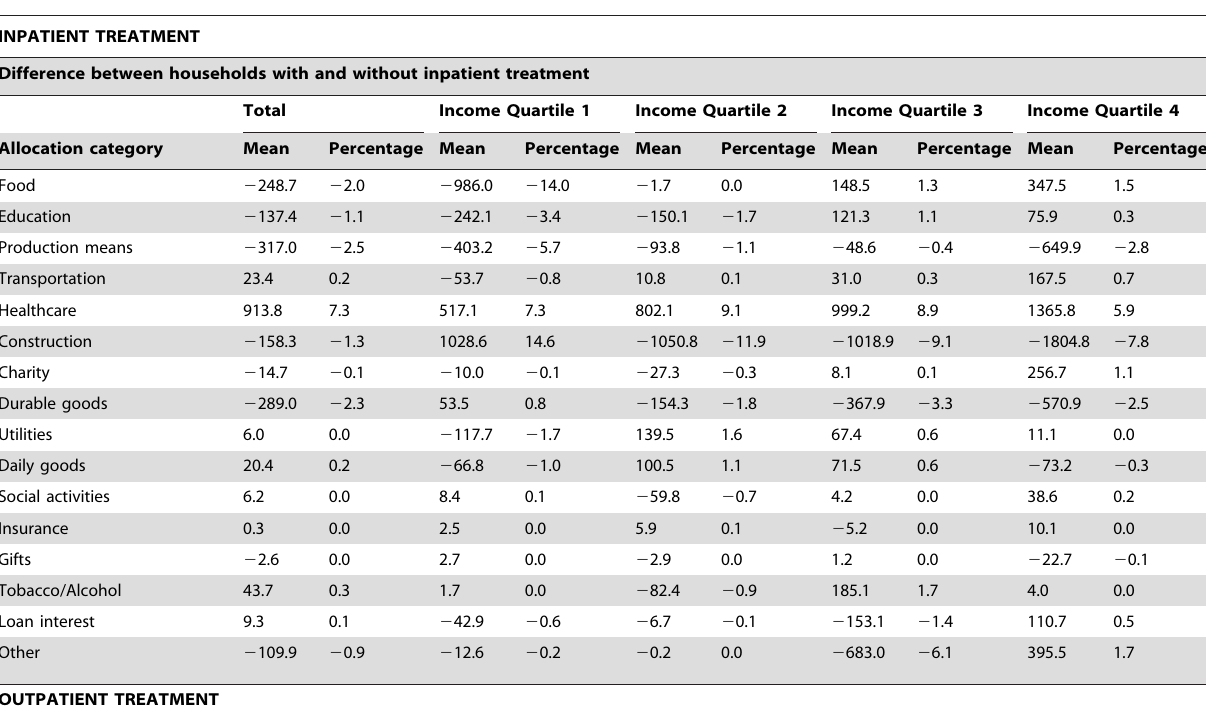
Table 5. Adjusted mean and percentage differences in allocation categories between households with and without inpatient treatment, and outpatient